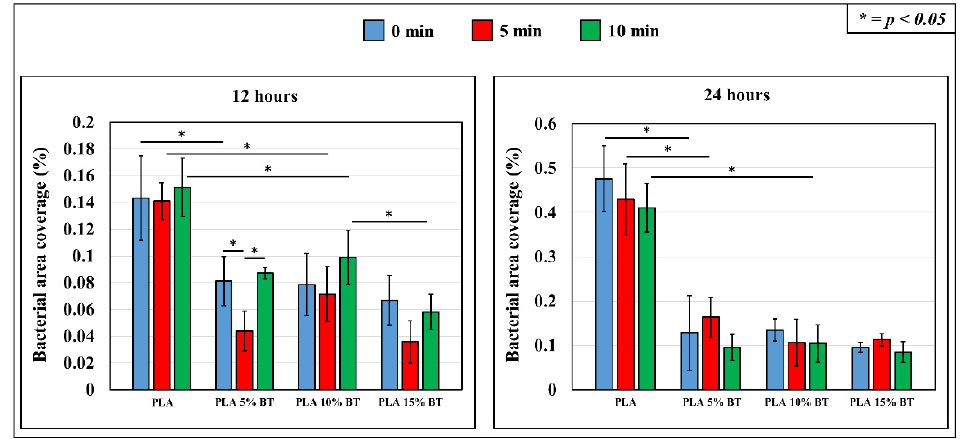
Figure 13. Quantitative assessment of fluorescence microscope images of the four samples collected at S. epidermidis exposure time of 12 and 24 h and validated by statistical analysis.